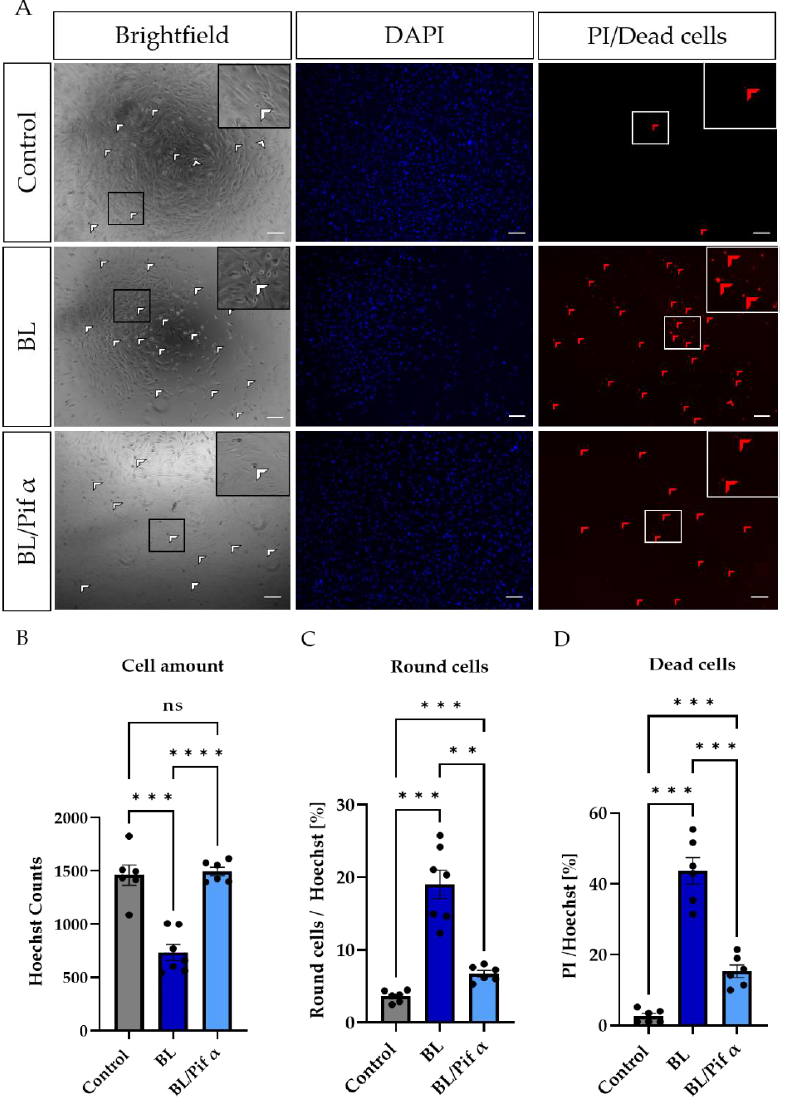
Figure 7. Treatment with pifithrin α significantly reduced apoptotic cell death in primary Müller cell- derived cells. Müller cell-derived cells (MCs) were exposed to BL (30 mW/cm 2 ) for 1.5 h and further cultivated for 24 h. MCs were treated with 1 µ M pifithrin α immediately after exposure. ( A ) Bright- field images revealed more round cells (white arrows) in BL-exposed MCs, with a reduction in number following pifithrin α treatment. Moreover, BL induced more PI-positive (thus dead) cells (red arrows), with this number again reduced by pifithrin α . ( B ) MCs were stained with Hoechst to quantify the cell amount per condition. Significantly fewer cells were counted after BL exposure; however, due to pifithrin α treatment, an equal number of cells to the control were observed. ( C ) Treatment with pifithrin α strongly reduced the number of round cells after BL exposure. The counted number of round cells was normalized by Hoechst staining in each sample (round cells/Hoechst) to show the percentage of round cells. ( D ) Significantly more PI-positive cells (i.e., dead cells with ruptured membranes) were observed following BL exposure. Treatment with pifithrin α decreased the number of PI-positive cells. The number of PI-positive cells was normalized by Hoechst staining in each sample (PI/Hoechst) to demonstrate the percentage of dead cells. n = 6/condition, analyzed using ImageJ. Bar graphs represent the mean values and SEM. Statistical differences are indicated as follows: ns: not significant, ** p < 0.01, *** p < 0.001, and **** p < 0.0001 compared to control/BL, according to Welch’s one-way ANOVA. Scale bar: 200 µ